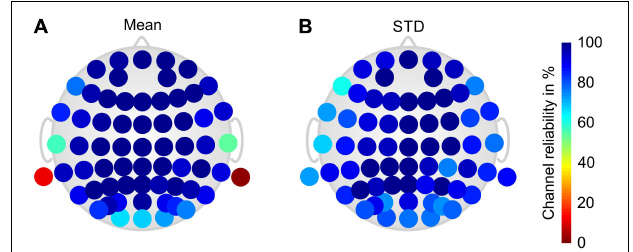
FIGURE 3 | Color-coded topographic plots of the relative channel reliability of the gel-based electrode cap, evaluated by two EEG experts and calculated over all volunteers and phases of the paradigm: (A) mean and (B) STD. Orientation of the topographic plot: nose on top.